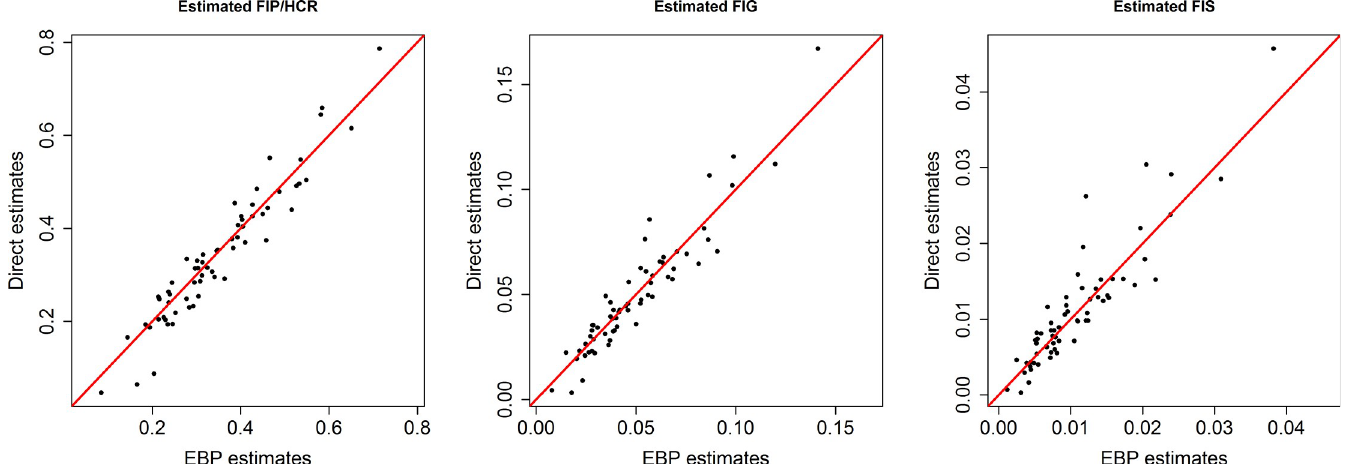
Fig 2. Bias diagnostics plots of FIP/HCR (left), FIG (centre), and FIS (right) food insecurity indicators generated by the EBP method with y = x line (solid) and regression line (dotted).